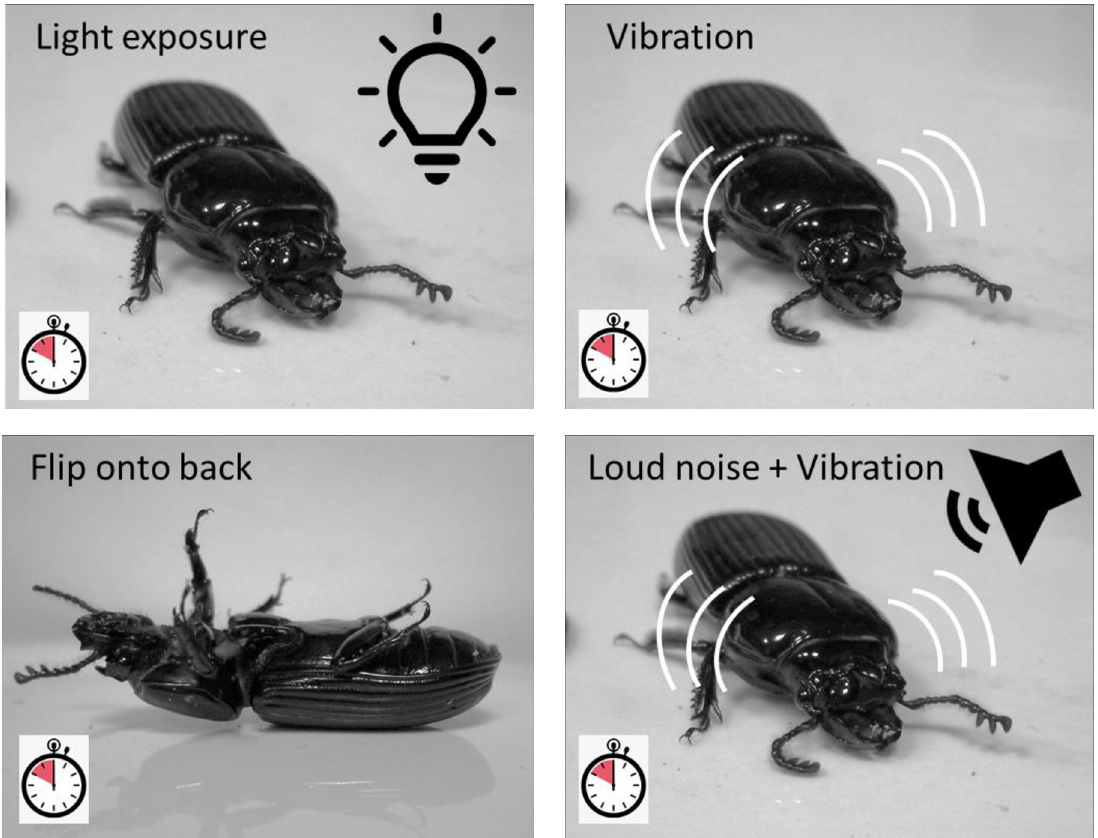
Fig 2. Stressor treatments applied to beetles to induce freezing behavior. Beetles were placed in a tabletop arena and exposed to one of four mild stressors, after which we timed the duration of freezing. Stressors included light exposure, flipping the beetle on its back, vibrating the arena (using a cell phone app) and vibration plus rapping the arena with a metal probe (loud sound). Each beetle was subjected to all four treatments on differing days (one treatment per day), and we averaged the durations of all